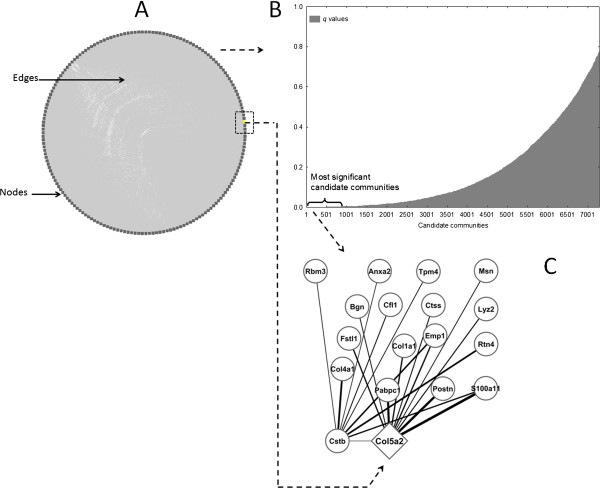
Gene co-expression network in MI encodes clinically interesting knowledge. A. Graphical view of the network. Nodes and edges represent genes and co-expression relationships respectively. Because genes are highly densely interconnected, edges are difficult to graphically discern, and here are shown as a grey area inside the (circle) network layout. B. Overview of the statistical landscape of network communities detected. The q values reflect the statistical relevance of the candidate communities. C. A highly interconnected and co-expressed community, in which Col5a2 is shown as a potential relevant gene with predictive value. The thickness of the edges reflects the observed co-expression values.